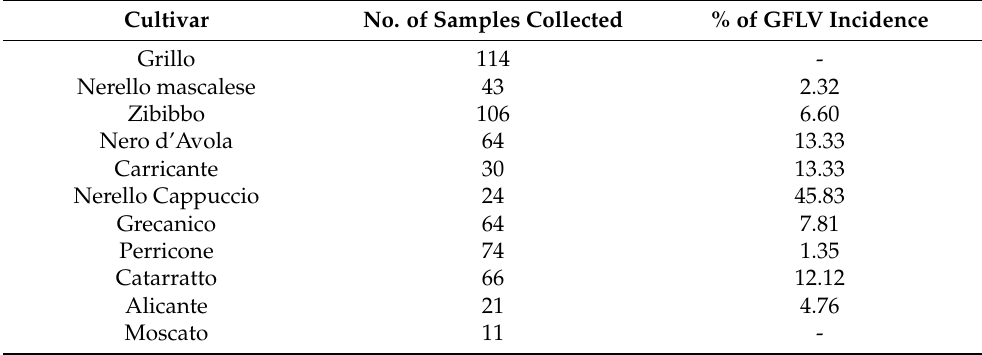
Table 4. Percentage of incidence for each cultivar tested by specific RT-PCR end point for Grapevine fanleaf